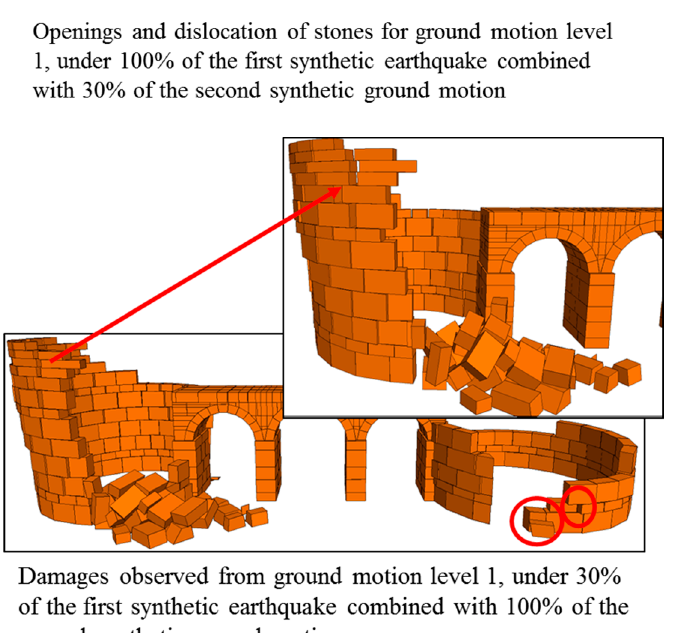
Figure 14. Damage patterns under the Dinar, Turkey 1995 earthquake and synthetic earthquakes. Under real and synthetic earthquakes, time histories of displacements relative to the base of the model were evaluated at five points, shown in Figure 15. It is obvious from these that under the Dinar earthquake and the synthetic motions, the round towers and the gate show quite di ff erent movements, with the arched gate displaying lower values. The maximum values of displacements relative to